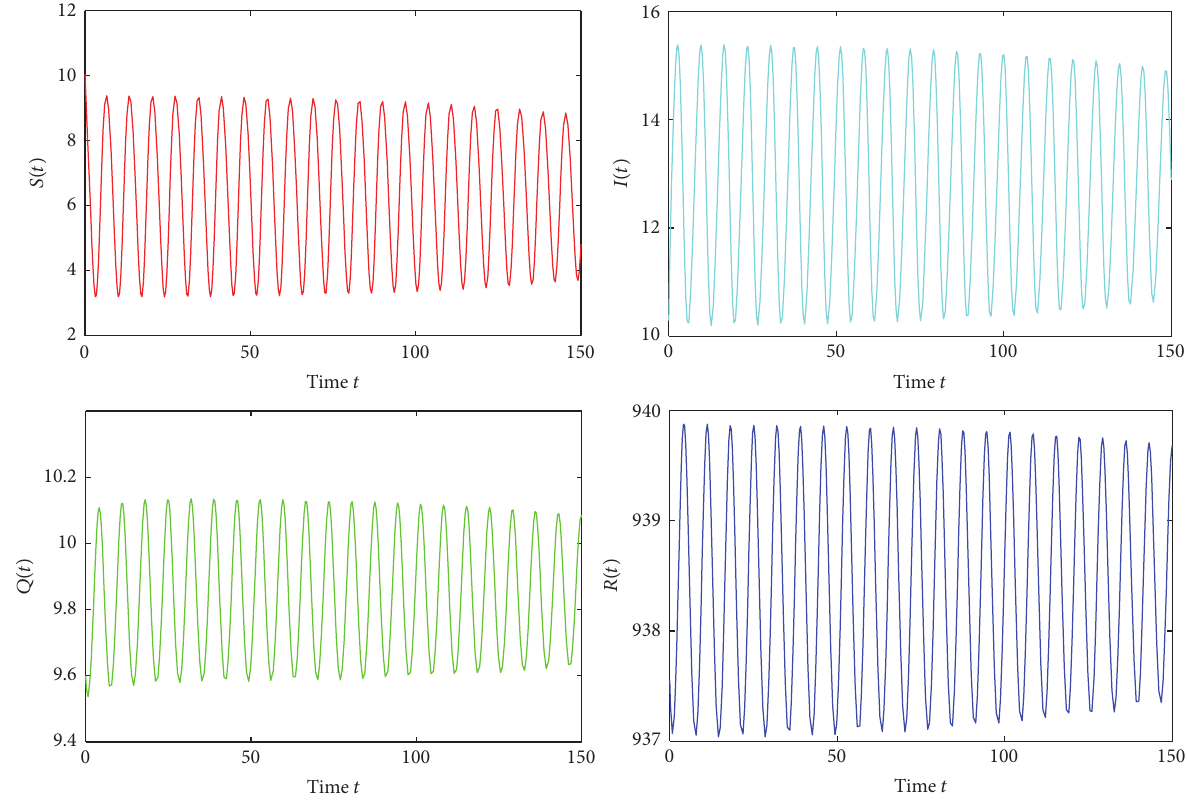
Figure 4: The trajectory of 𝑆 , 𝐼 , 𝑄 , and 𝑅 when 𝜏 1 = 1.3625 > 1.3265 = 𝜏 10 .